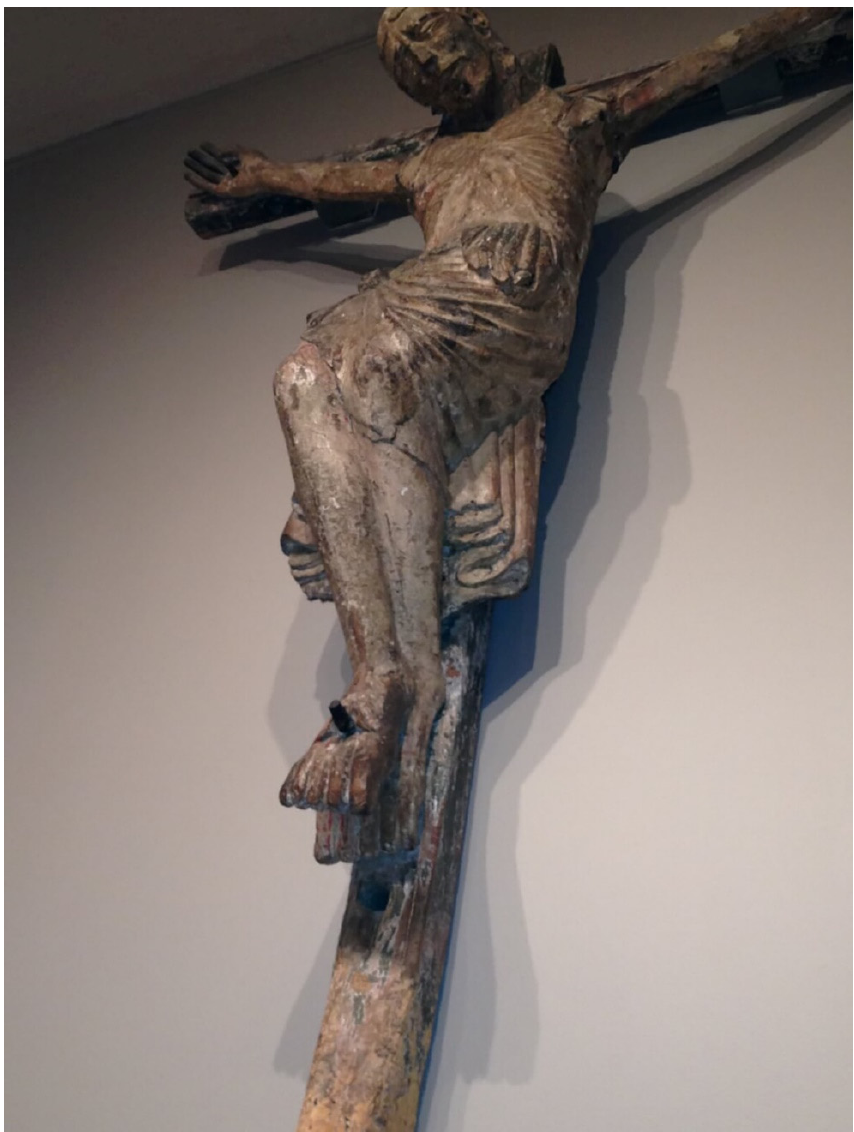
Figure A3. Crucifix, unknown Spanish, early 13th century, detail. Source: 52.34 Memorial Art Gallery of the University of Rochester. (Photograph taken by the author).